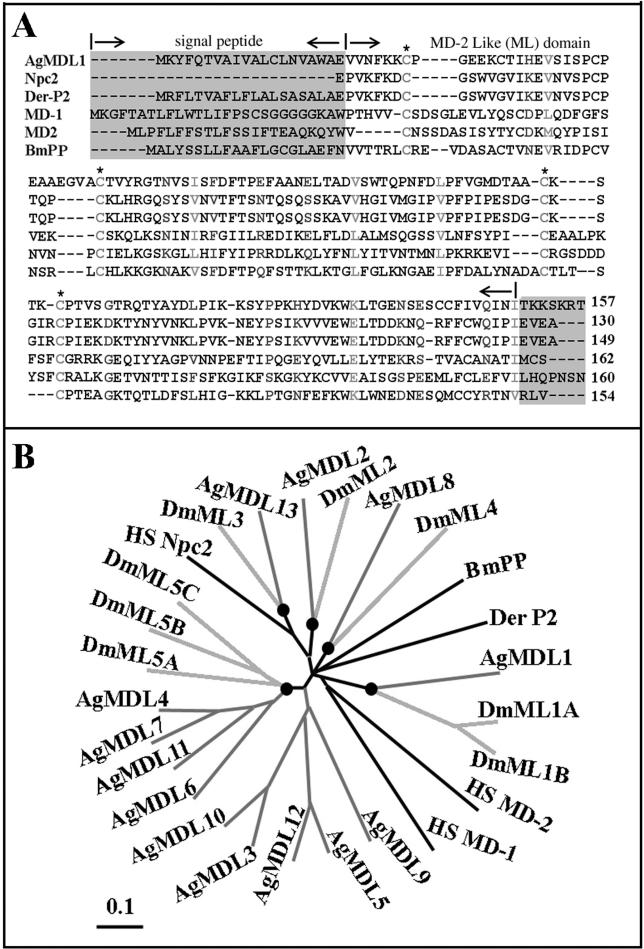
AgMDL Gene Family(A) A. gambiae MD2-like genes encode proteins ranging from 130 to 162 amino acids and include signal peptides and an ML lipid recognition domain. Alignment of AgMDL1 with the human homologues MD1, MD2, and Npc2, the mite allergen Der-P2, and the Bombyx mori promotor protein (BmPP). Two conserved cysteines, Cys95 and Cys105, that are essential for binding to TLR4 are indicated with asterisks.(B) Phylogenetic tree of MD2-like proteins from A. gambiae, D. melanogaster, B. mori, and humans. 1:1 orthologs and ortholog groups are highlighted with filled circles. Ag, Anopheles gambiae; Dm, D. melanogaster. The accession numbers for these genes are listed in Table S7.